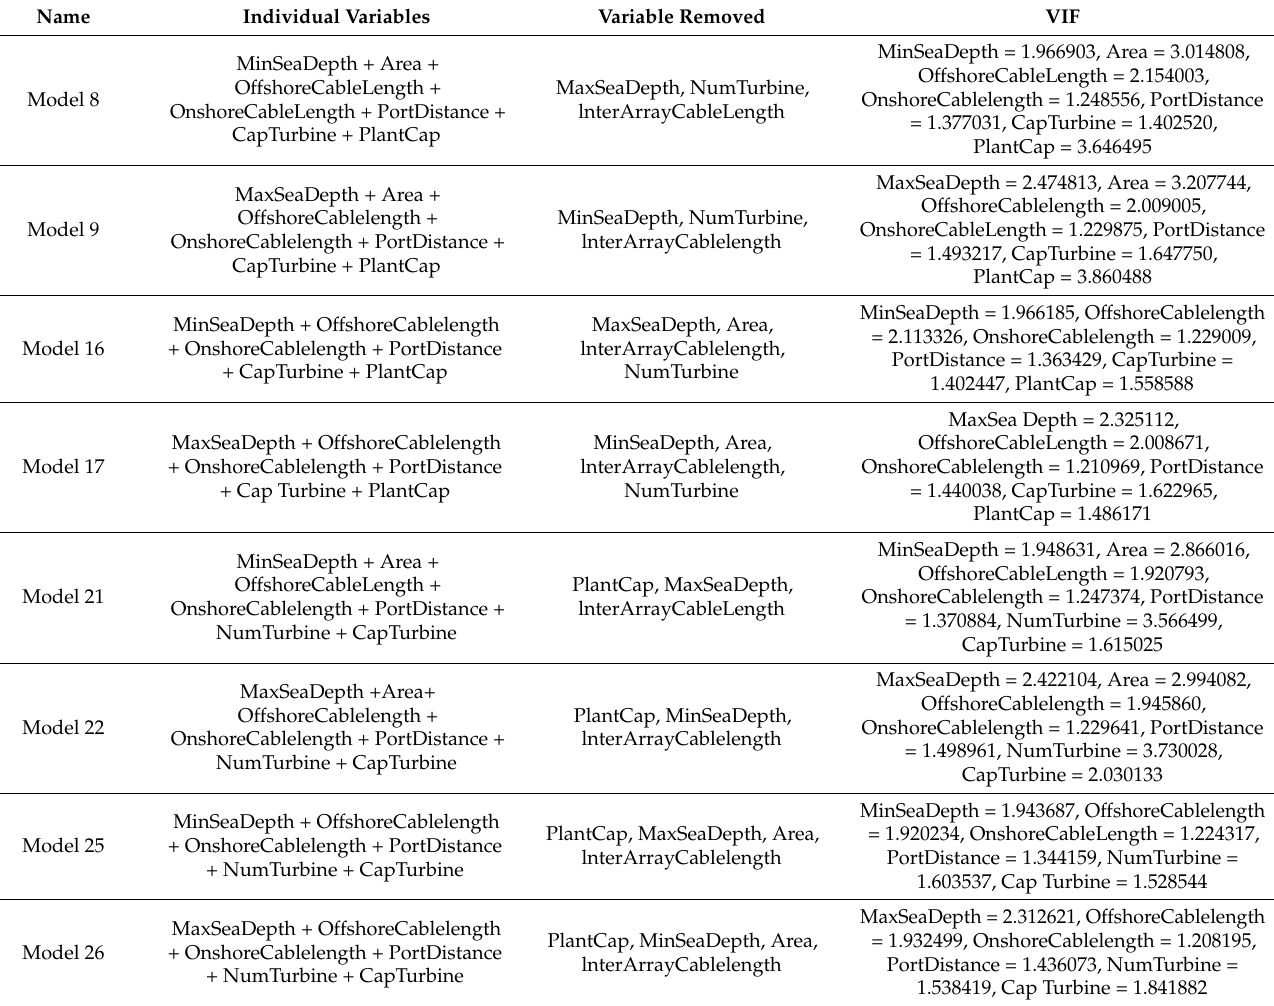
Table 1. Variance inflation factor of the different models of independent